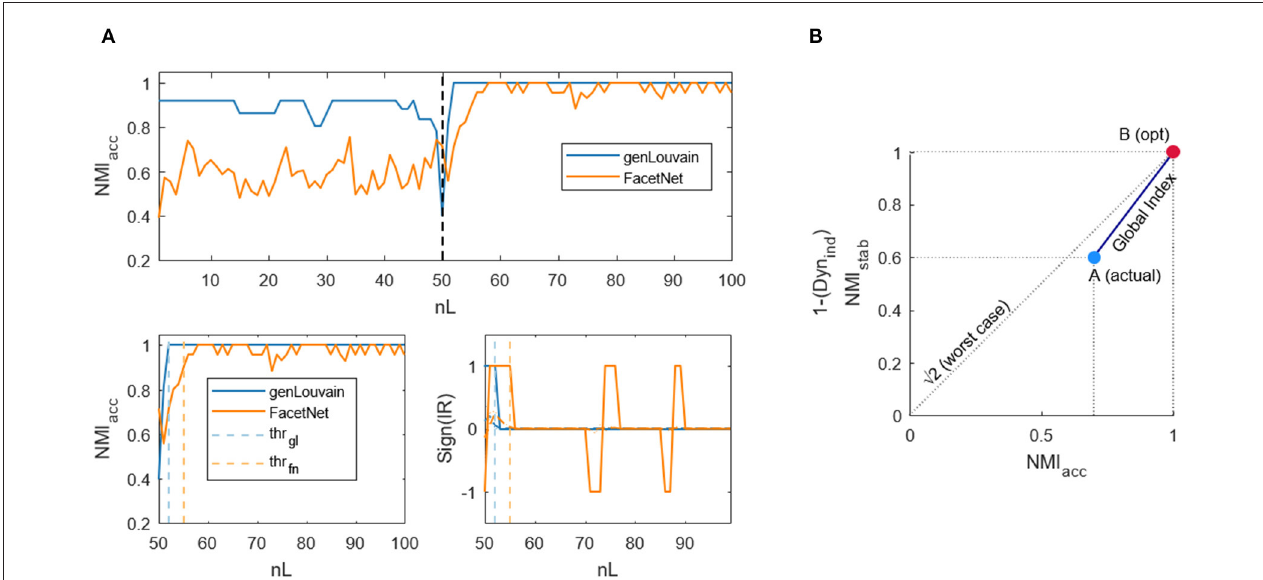
FIGURE 2 | Example of dynamic and global indices computation. (A) Dynamic index. Top figure: normalized mutual information computed between the output of the algorithms genLouvain and FacetNet and the actual community structure of a generated network with 100 layers. Lower left figure: normalized mutual information from the snapshot in which community structure changes and threshold samples (from which the algorithms go to regime) identified through the dynamic index. Lower right figure: sign of the first derivative smoothed and threshold samples. (B) The global index is indicated with the dark blue continuous line. A is the point corresponding to the actual values of NMI acc and NMI stab /Dyn ind , while B is the point corresponding to the maximum values reachable by the